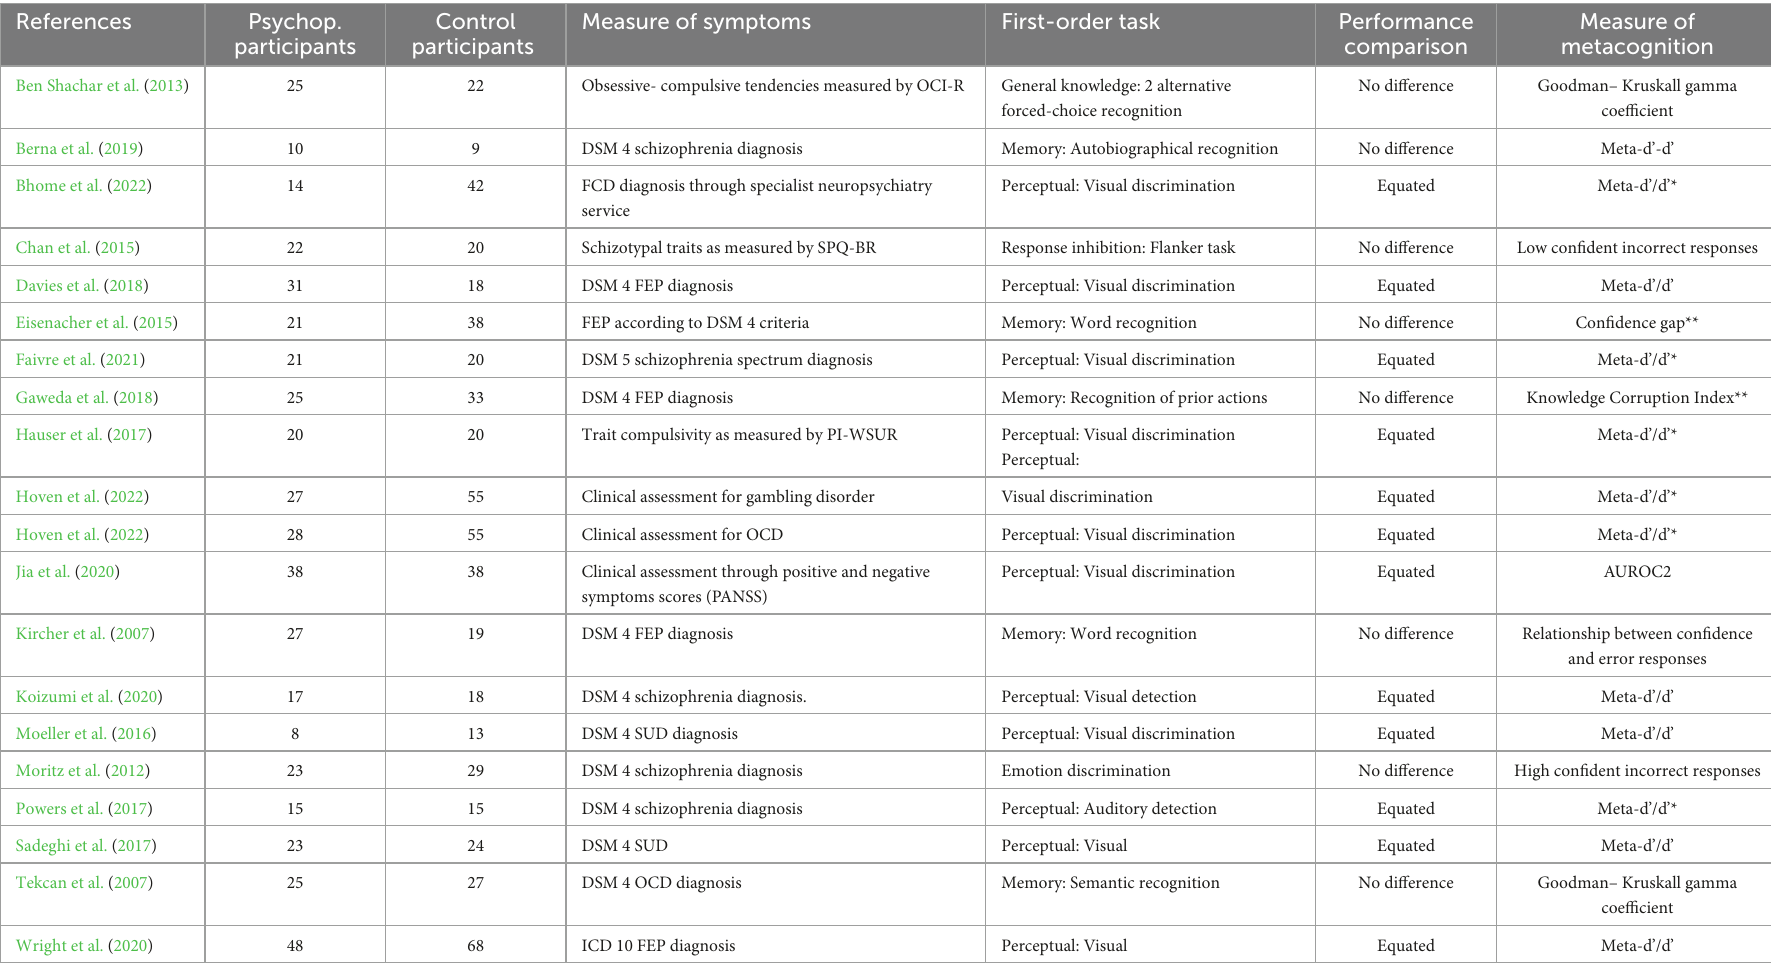
TABLE 4 Characteristics of studies included in the review: ‘Psuchop. Participants’ refers to psychopathological